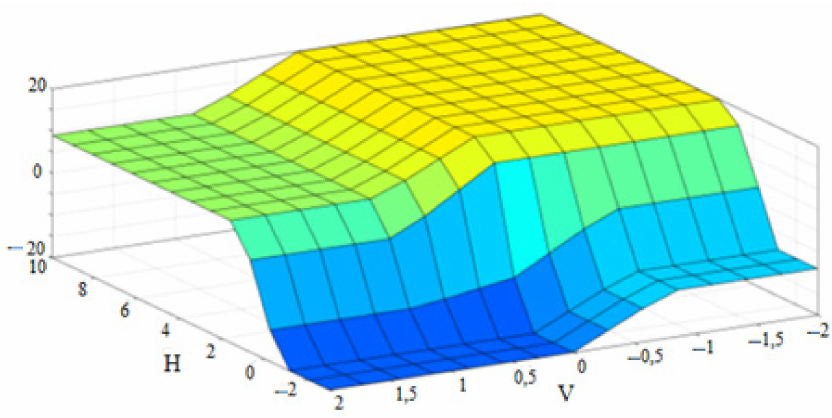
Figure 5. The surface of the fuzzy